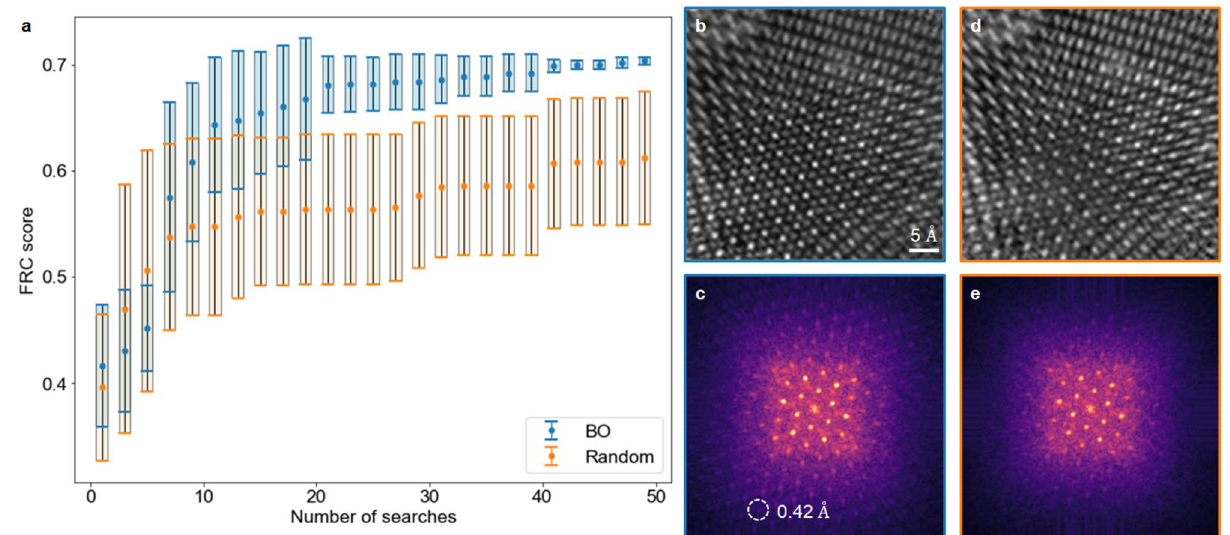
Figure 2. Performance of Bayesian optimization versus a random search. ( a ) Plot of FRC score behavior over the number of parameter searches using BO versus a random search strategy. In 10 trials, BO consistently outperforms random search with higher FRC score and lower uncertainties as the number of parameter searches increases. ( b , d ) Best reconstruction for one trial after 50 parameter searches using ( b ) Bayesian optimization and ( d ) random search. ( c , e ) Diffractograms of reconstructions in ( b ) and ( d ),